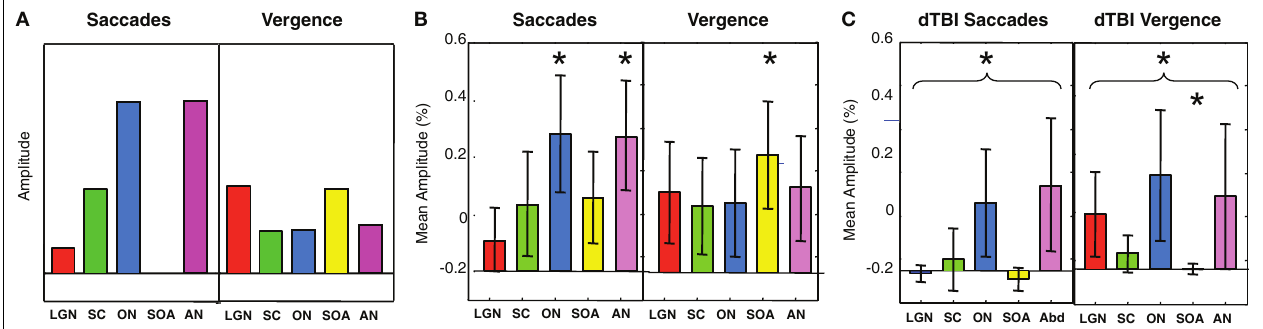
geniculate nuclei; SC, superior colliculi; ON, oculomotor nuclei; SOAs, supra-oculomotor areas; AN, abducens nuclei. Error bars are 1 SEM. Oculomotor nucleus activation significantly different from 0 at p < 0.05 on the t -test after correction for multiple planned comparisons are indicated by an